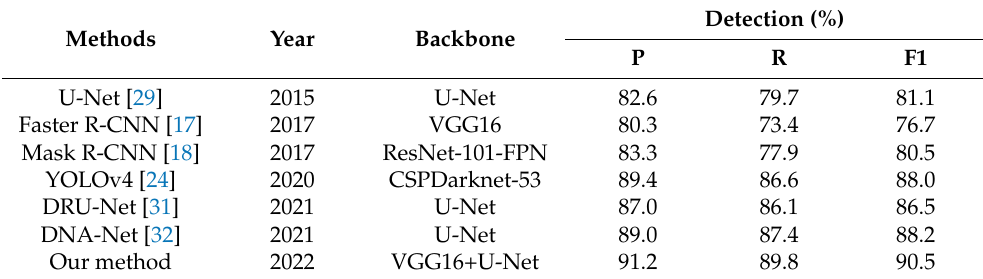
Table 2. Comparison of detection performance on the bird